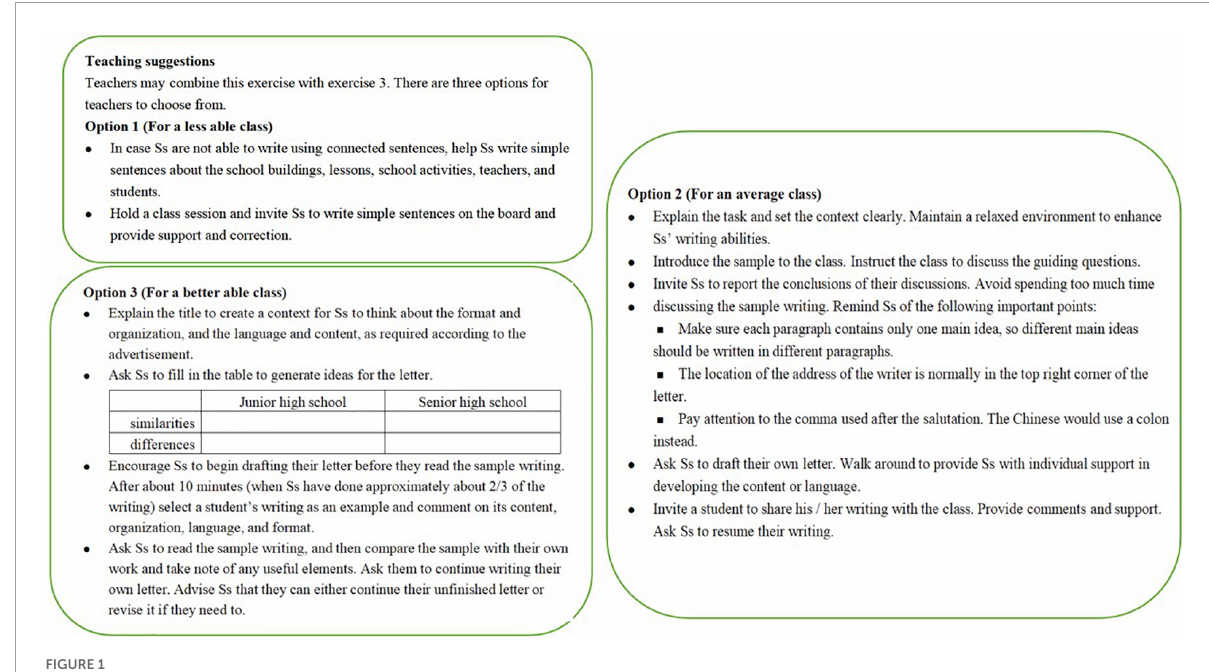
FIGURE1 The options for teaching suggestions on a writing